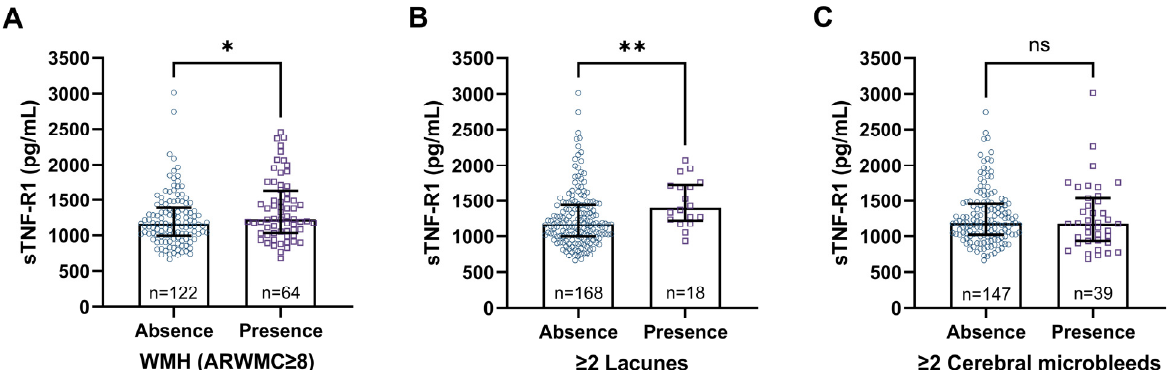
Figure 1. Serum sTNF-R1 concentrations in predementia subjects with CSVD. Bar graphs are median sTNF-R1 values ± interquartile range (IQR) stratified by the absence vs. presence of significant ( A ) WMH, ( B ) lacunes and ( C ) cerebral microbleeds (see Section 2.5 on neuroimaging for definitions). Datapoints represent available individual measures. * p < 0.05, ** p < 0.01, ns: not significant, pairwise comparisons using independent-samples Mann–Whitney U-tests. ARWMC = age-related white matter changes; n = number of cases; WMH = white matter hyperintensities. Table 2. Association between serum sTNF-R1 tertiles and CSVD markers at baseline 1 .